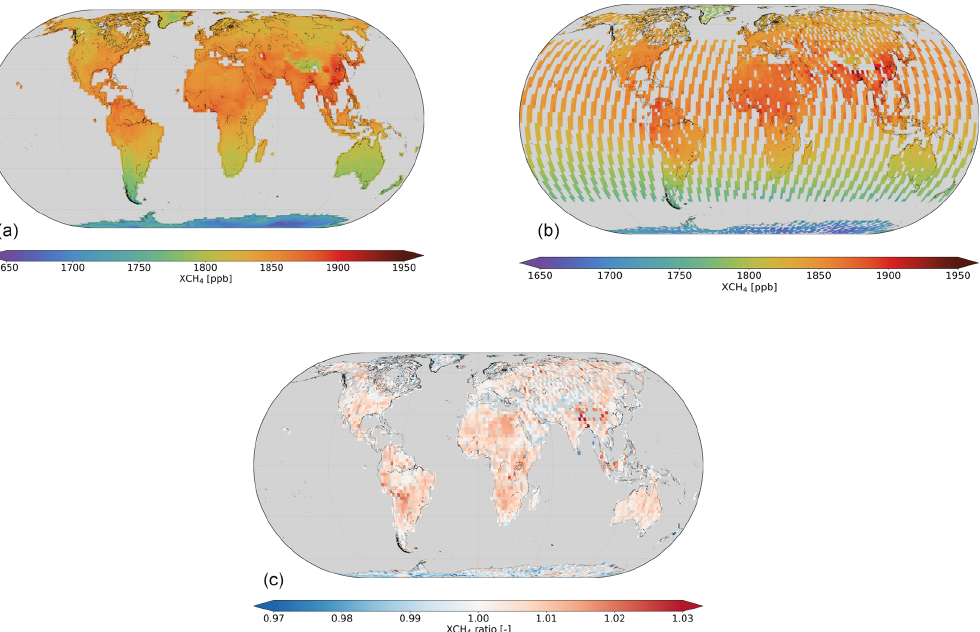
Figure 10. Global distribution of XCH 4 measured by (a) TROPOMI and (b) GOSAT and (c) the ratio of GOSAT to TROPOMI XCH 4 . Daily collocations are averaged to a 2 ◦ × 2 ◦ grid for the period 1 January 2018–31 December 2019.